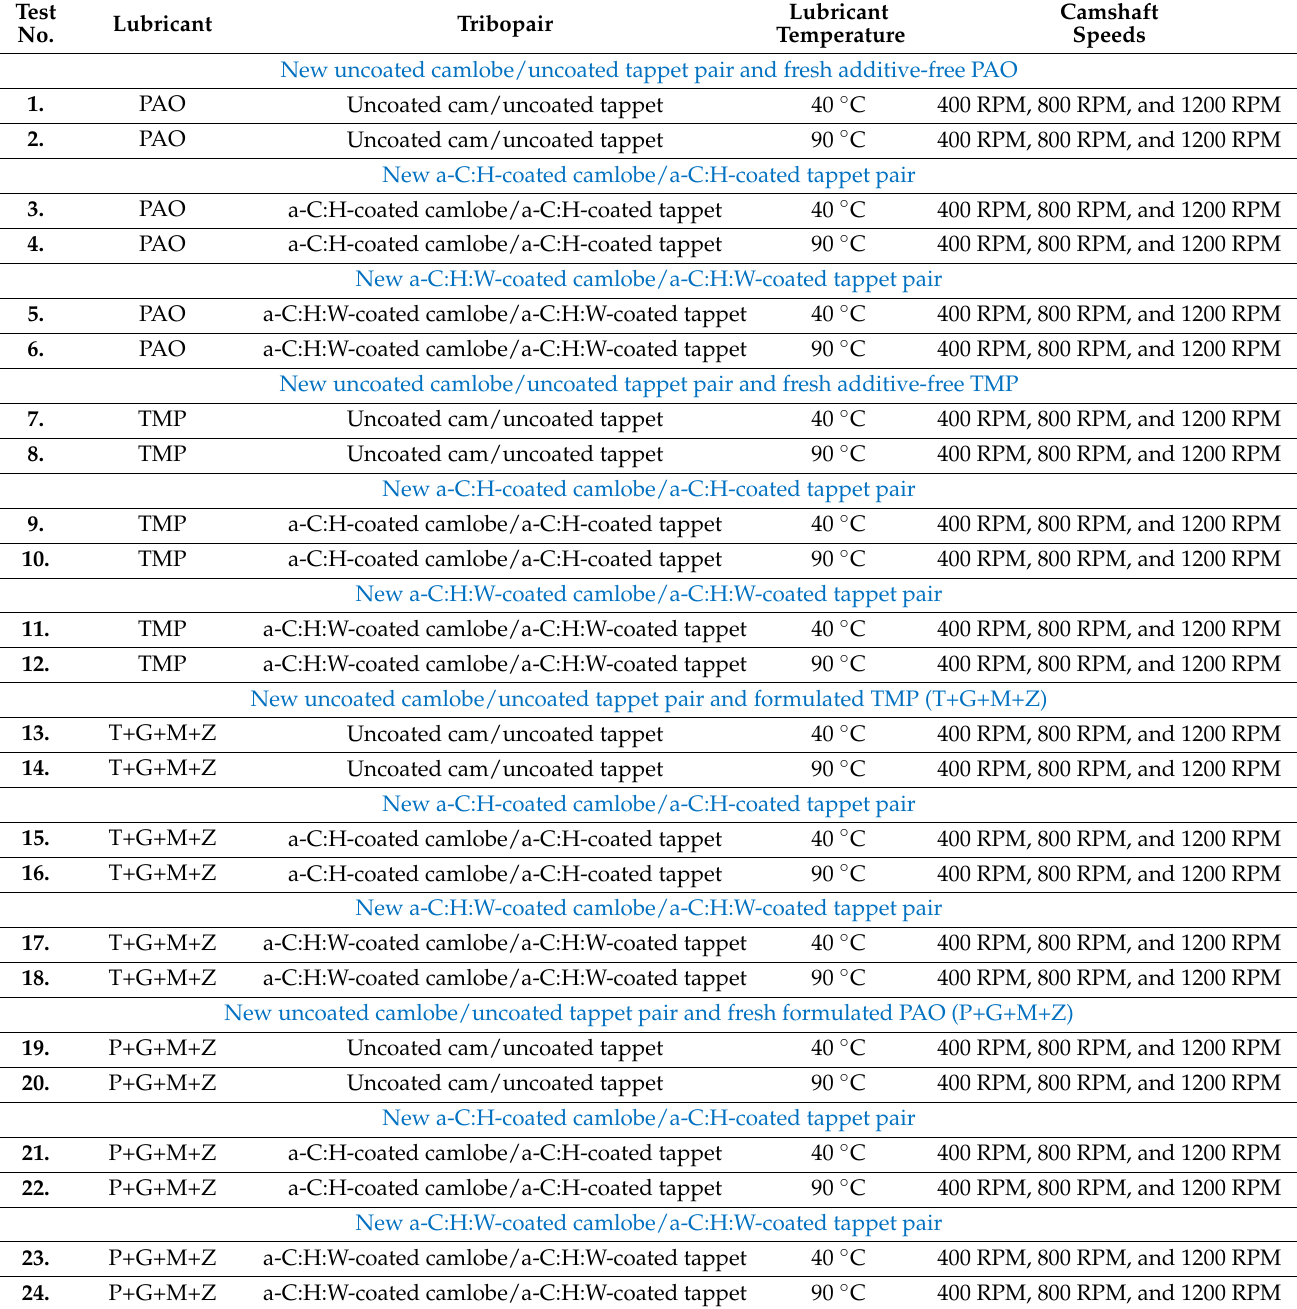
Table 4. Test matrix for cylinder head